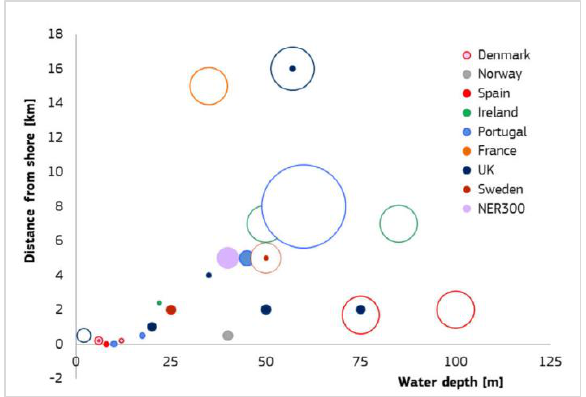
Figure 1. Wave energy deployment: water depth vs. distance from shore. Note: the size of the bubble refers to the capacity of installed projects (full circle) or the maximum site capacity (circles). Source: courtesy of Davide Magagna [18].